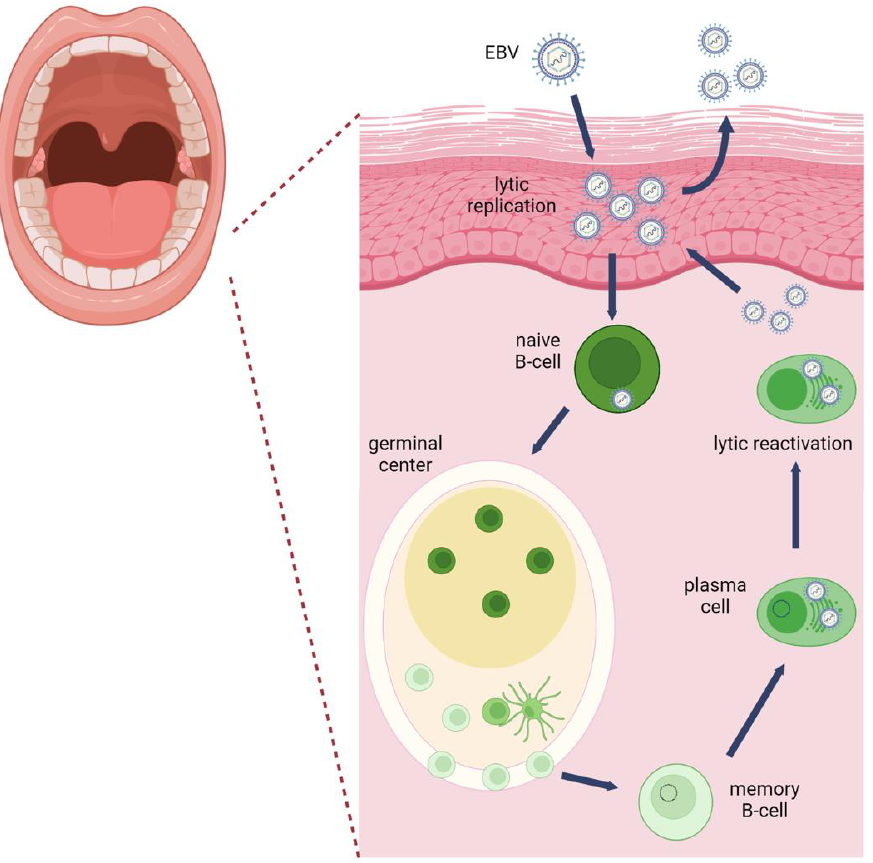
Figure 1. Life cycle of EBV within the oral cavity. EBV is transmitted via saliva and infects oral epithelial cells. Epithelial cells support productive viral replication in the upper differentiated layers of the epithelium. In B cells, EBV adopts various latency programs that support B cell maturation/differentiation and promote B cell growth and survival. As long-lived cells, memory B cells provide a life-long reservoir for EBV as a latent infection. Differentiation of memory B-cells to plasma cells stimulates EBV reactivation to produce new progeny virions that infect the epithelium for shed in saliva or re-infection of other naïve B-cells. Image was created with